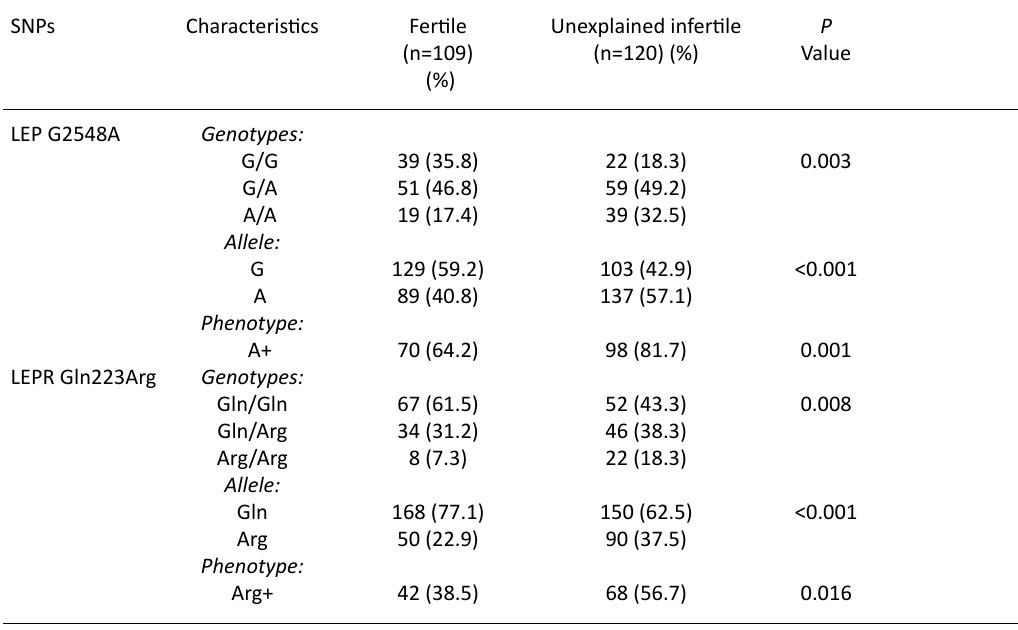
Table 3. Frequency distribution of LEP G-2548A and LEPR Gln223Arg polymorphisms between two groups (Wild: G/G or Gln/Gln, Heterozygous: G/A or Gln/Arg, Homogygous mutant: A/A or